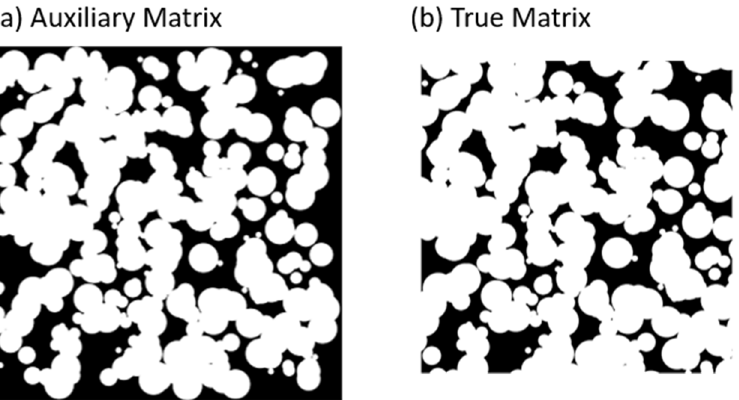
Figure 5. Example of the full process for circle Matrices shape resulting from applying initial parameters and geometries. ( a ) shows AuxiliaryMatrix with zeros and ones assigned and ( b ) shows the composition of the resulting matrix (TrueMatrix) from the image cropping of the auxiliary matrix.